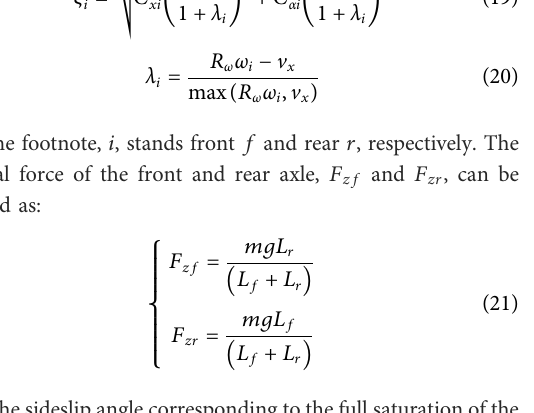
FIGURE 3 Comparison of yaw rate.